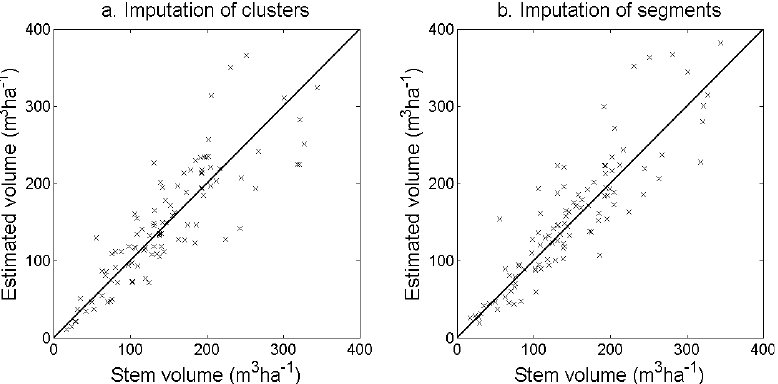
Figure 13. Stem volume at plot level estimated from ( a ) imputation of clusters with model Cluster1 and ( b ) imputation of segments with model Segment1.